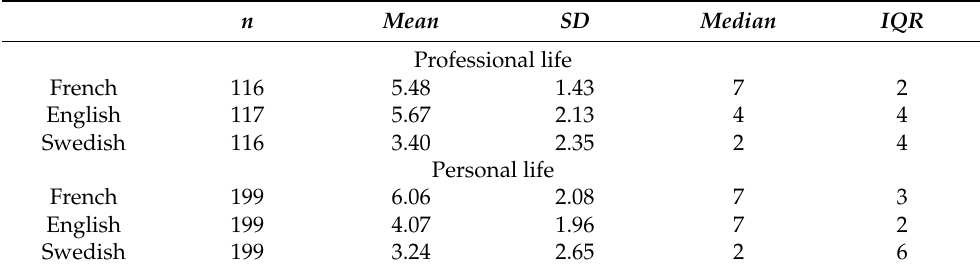
Table 3. The number of participants ( n ), mean, standard deviation ( SD ), median, and interquartile range ( IQR ) for the perceived importance of skills in French, English, and Swedish. The statistics are presented first for professional life and then for personal life. The minimum value of the scale was 1 and the maximum was 7. n Mean SD Median IQR Professional life French 116 5.48 1.43 7 2 English 117 5.67 2.13 4 4 Swedish 116 3.40 2.35 Personal life French 199 6.06 2.08 English 199 4.07 Swedish 199 3.24